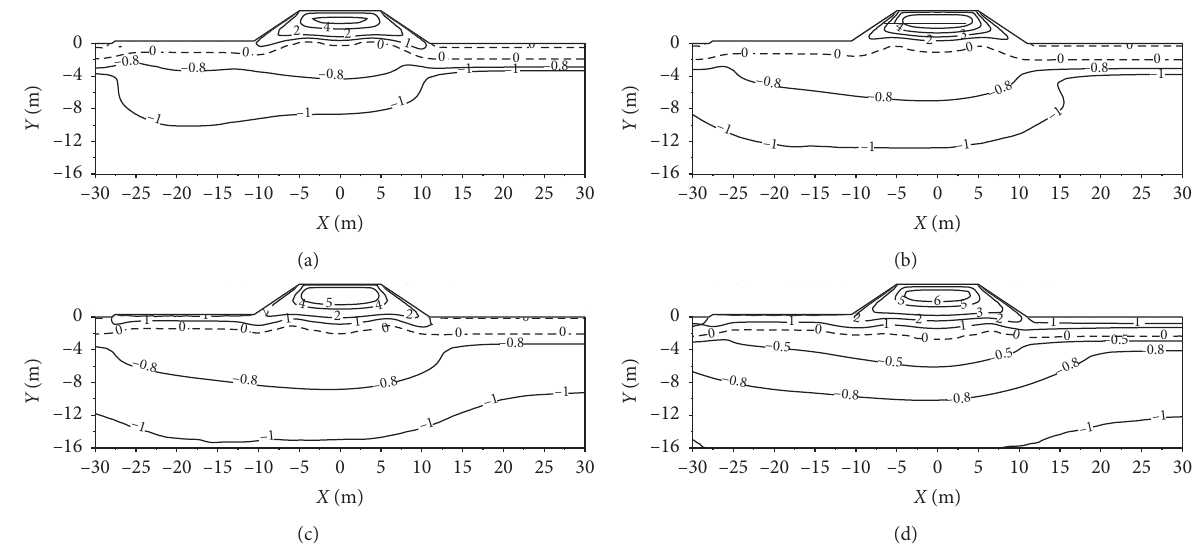
Figure 11: Distribution of the temperature field beneath the SE with the sand deposition thickness of 0.3 m in cold season of 5a, 10a, 15a, and 20a (unit: °